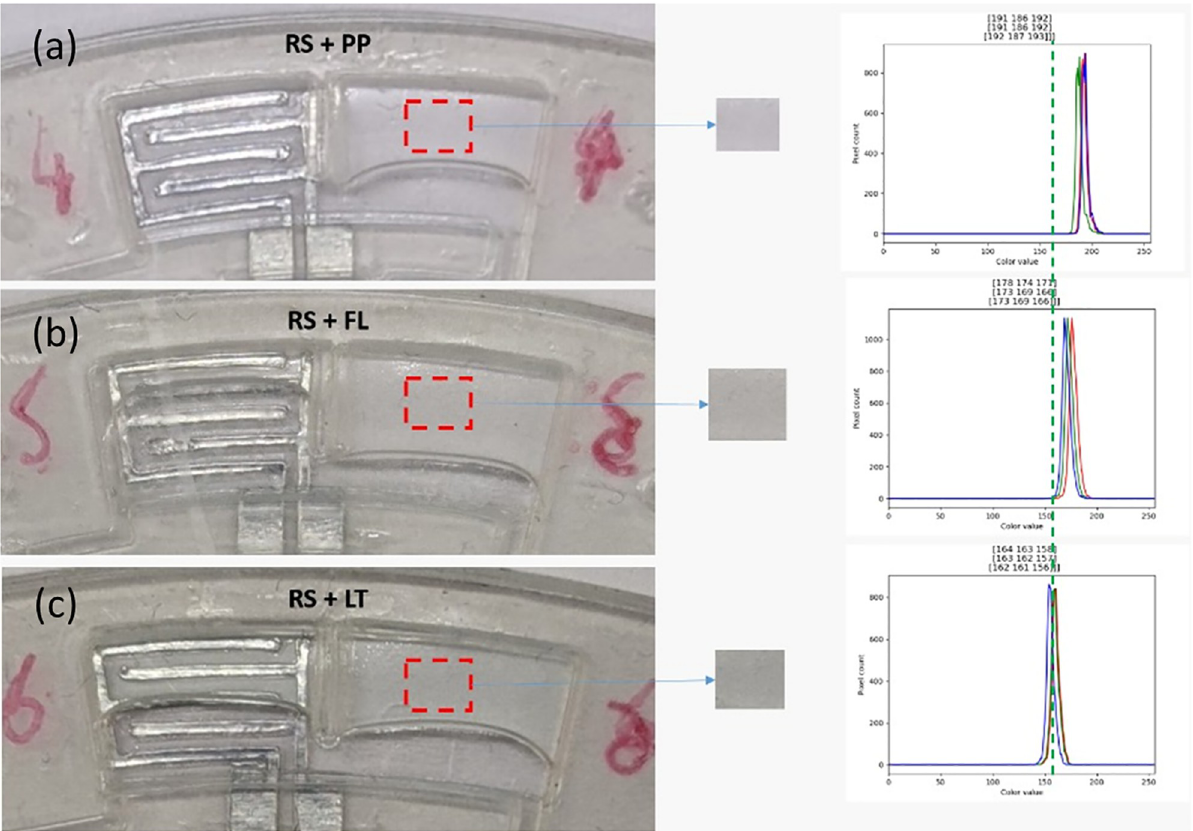
Fig 8. Mixing of real saliva (subject 1) and different mouthwashes (a) chlorhexidine-, fluoride-based mouthwashes and (c) Listerine and their respective RGB histogram analyses.